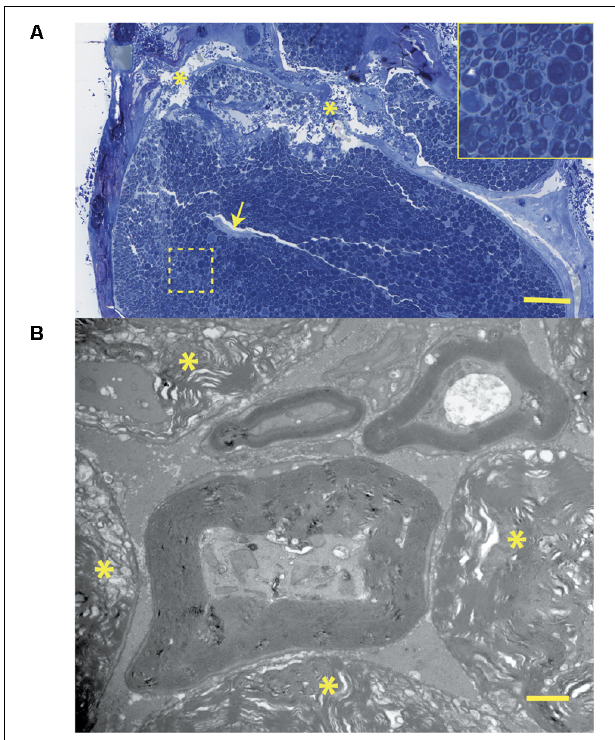
FIGURE 11 | (A) Histology corresponding to the CMAP tracing of Figure 7 : this transverse section through the crush zone shows the majority of myelinated axons are damaged. There are breaks in the perineurium (asterisks), a collapsed artery (arrow), and some superficial regions (near the periphery) containing small fibers that appear spared. The insert shows several axonal profiles that are non-myelinated. The two fascicles at the top supply the gastrocnemius muscle. Bar = 100 µ m. (B) At the ultrastructural level, from the same tissue specimen shown in Figure 6A , the details of nerve fiber breakdown, progressing from small to large, are seen. Note that small fibers may appear “normal” and that axoplasmic changes precede those involving the myelin sheath. The non-myelinated axons (top) also appear normal. The many myelin figures ( ∗ ) at the periphery all appear most advanced. Bar = 1 µ m, insert is an enlargement of the dotted line region.